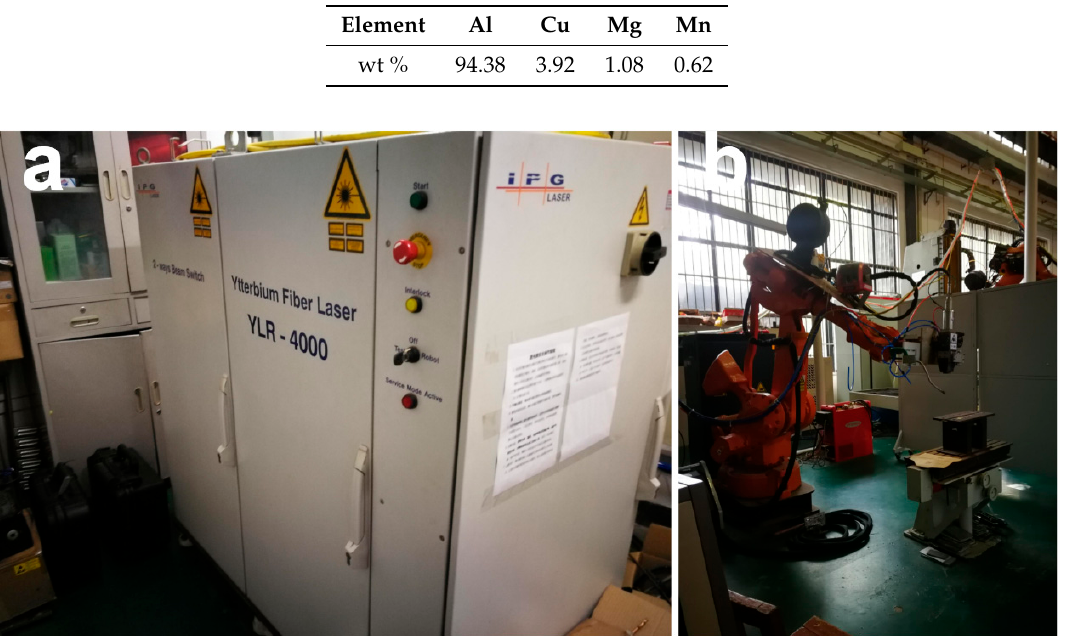
Figure 5. Welding devices: ( a ) IPG YLR-4000 fiber laser; ( b ) ABB IRB4400 robot. Table 3. The chemical composition of 2A12 in wt %.